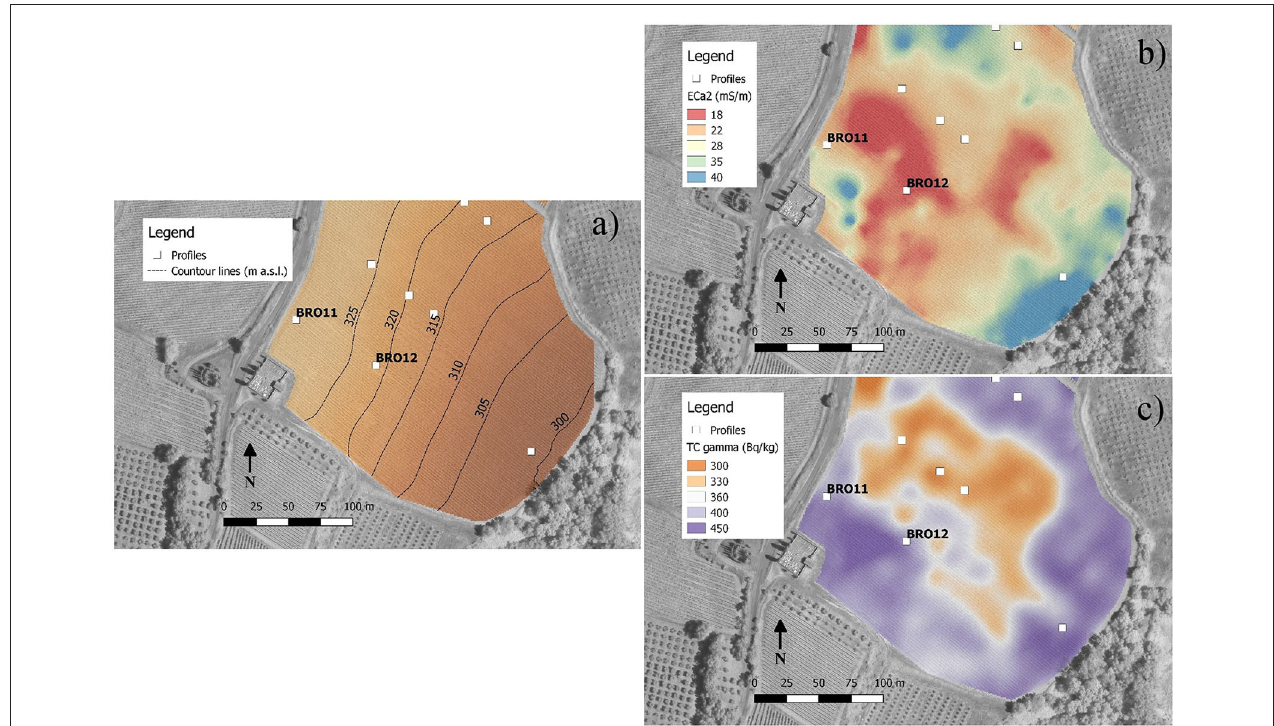
FIGURE 2 | Maps obtained by soil proximal sensing. (a) Contour lines of elevation (m a.s.l.); (b) apparent electrical conductivity for a soil depth of about 0–150cm (ECa2) measured by EM38-Mk2 and interpolated by ordinary kriging; (c) total counts of gamma-rays emitted from the topsoil (about